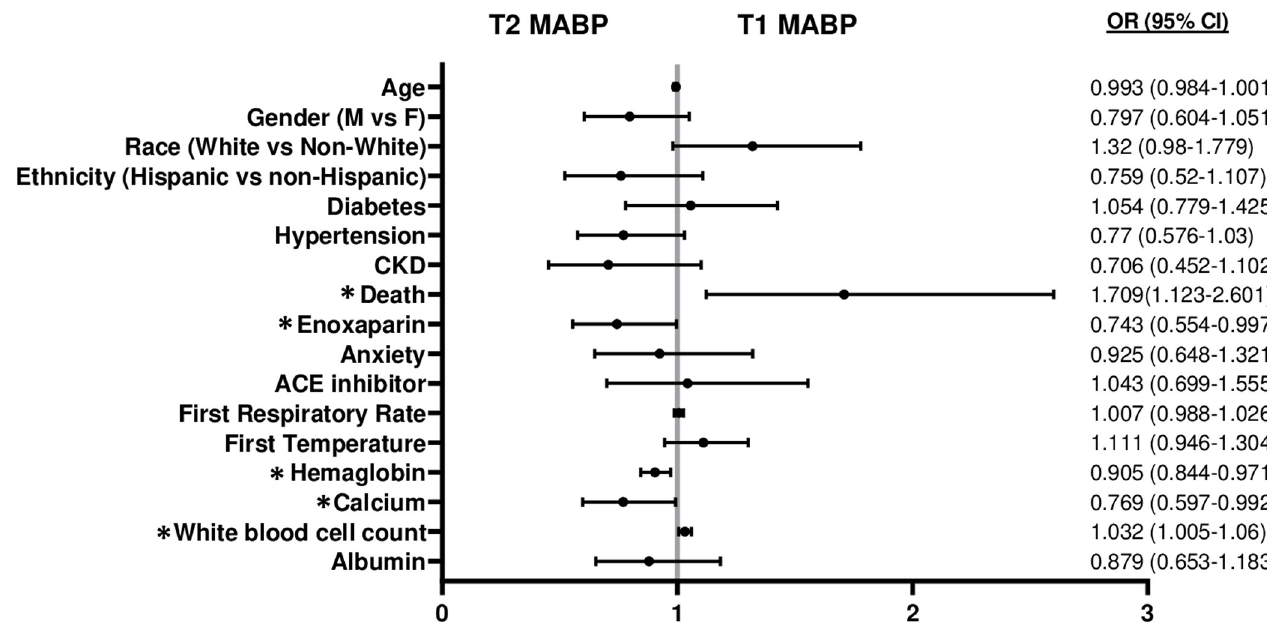
Fig 1. The odds ratio (OR) for patient characteristics that are associated T1 compared to T2 MABP in hospitalized COVID-19 (+) patients.